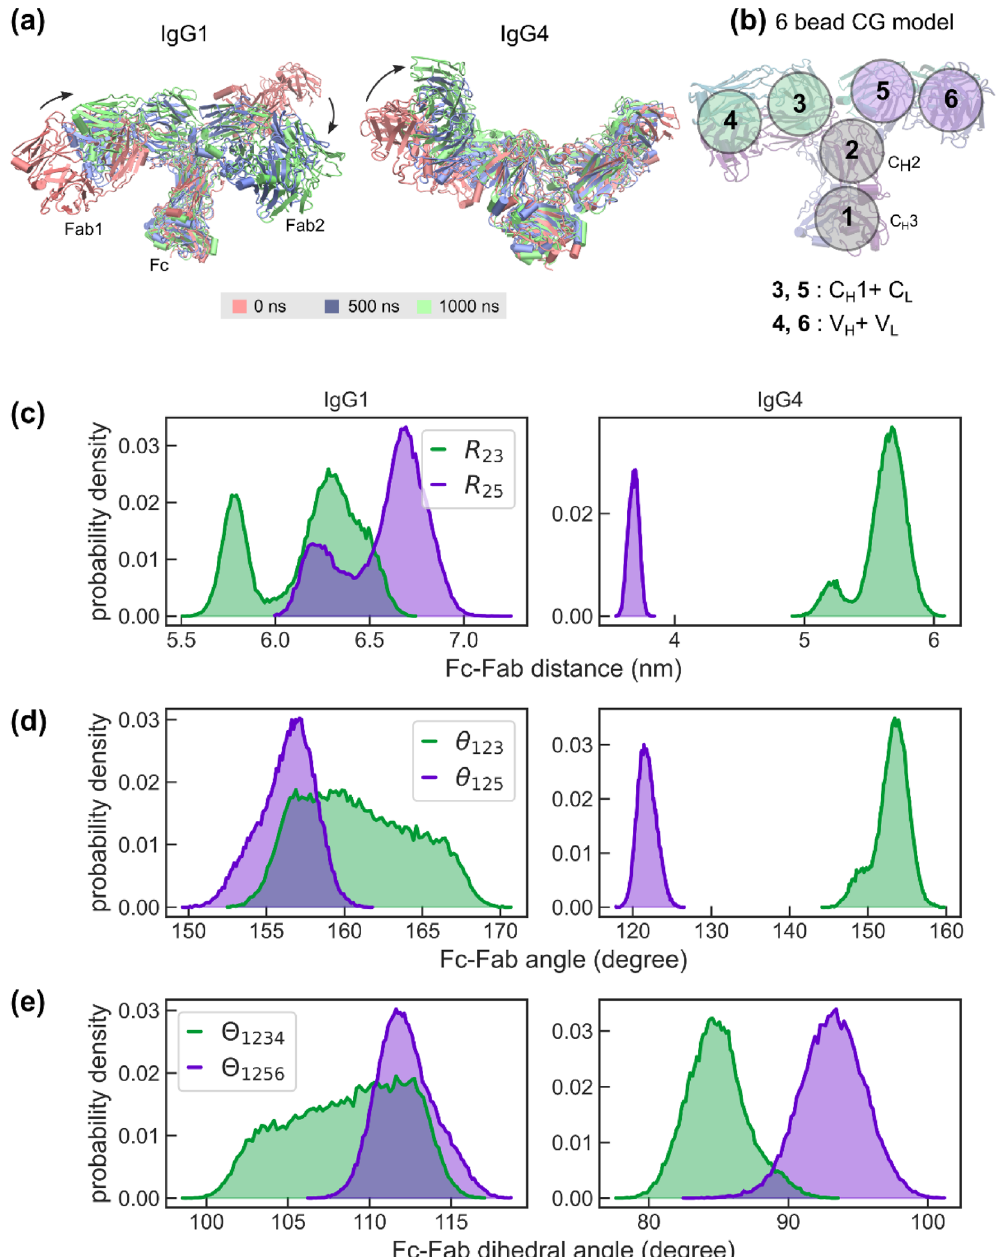
Figure 2. Dynamics of glycosylated IgG1 and IgG4 molecules generated using the AlphaFold predicted structures showing differential dynamics of the Fab arms. Data for the presented analysis were generated from 1000 ns implicit solvent simulations. ( a ) Comparison of antibody conformations at 0, 500, and 1000 ns showing large relaxation dynamics in the Fab domains for both IgG1 and IgG4 molecules. The arrows are a guide to the eye to mark the predominant directions of motion. ( b ) An illustration of the six-bead model used to quantify interdomain dynamics, with the antibody domains associated with each of the beads marked. ( c – e ) Probability densities of Fc–Fab distances ( R 23 and R 25 ), Fc–Fab angles ( θ 123 and θ 125 ), and Fc–Fab dihedral angles ( (cid:31) 1234 and (cid:31) 1256 ). Data for IgG1 and IgG4 molecules are shown in the left and right panels,